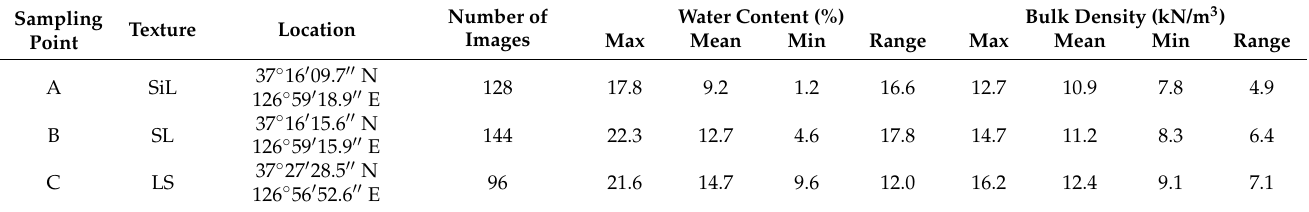
Table 1. Soil water content and bulk density of in situ soil